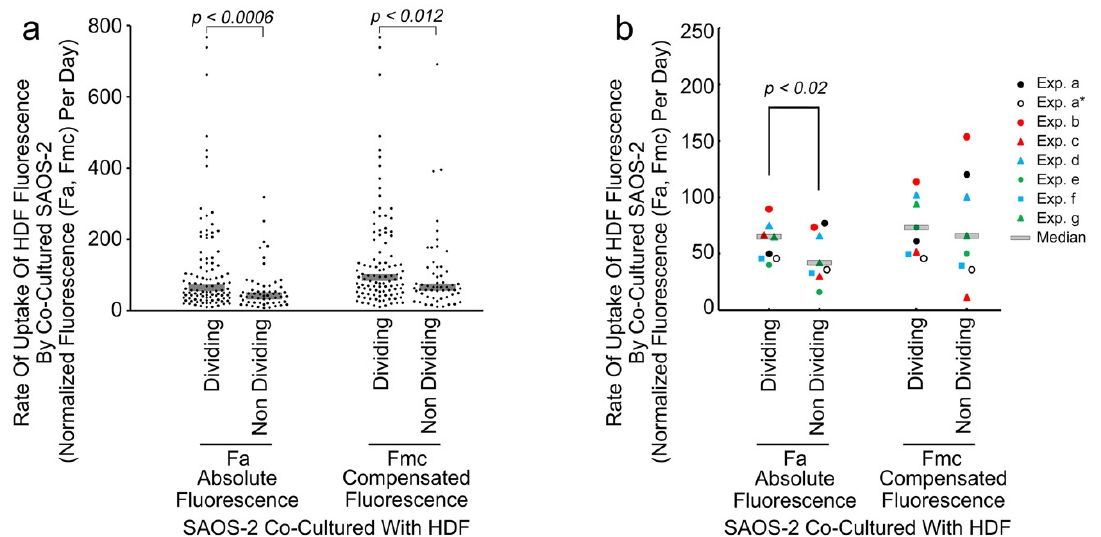
Figure 7. Scattergram showing results of a typical experiment (experiment g) showing the rate of uptake of normalized HDF fluorescence by individual co-cultured SAOS-2 cells, according to whether cells underwent subsequent cell division or not ( a ), as well as median values from all experiments ( b ). Fluorescence is expressed as the rate of uptake of absolute fluorescence measured (Fa/day), as well as with numerical compensation for halving of fluorescence by cell division in mother cells (Fmc/day). ( a ) Dividing cells had clearly higher values for Fa/day than non-dividing cells and this was statistically significant as marked (Mann–Whitney U test). A similar statistically significant difference was seen for Fmc/day. ( b ) Results for all experiments are shown, while experiment ‘a’, which showed atypical results for first-generation cells, is indicated twice—once including first-generation cells and once without (Exp. a*). The median rate of Fa uptake was higher in those cells that subsequently underwent division than in those that did not and this was statistically significant as marked when experiment ‘a’ first-generation cells only were considered, as well as when experiment ‘a’ was excluded from the analyses ( p < 0.032, Wilcoxon signed-rank test). The relationship for Fmc was similar although less consistent and was not statistically significant when all experiments were considered